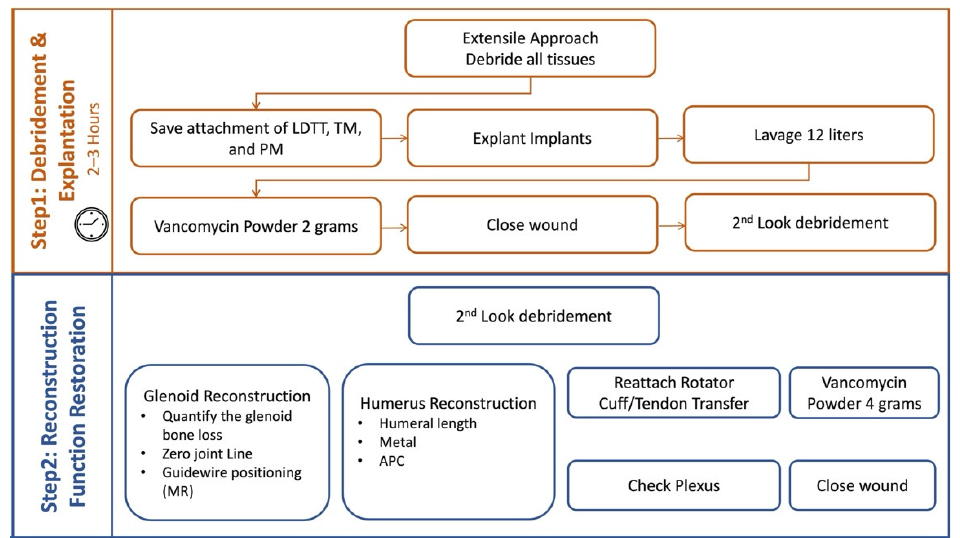
Figure 8. Surgical process for two-step single-stage revision shoulder